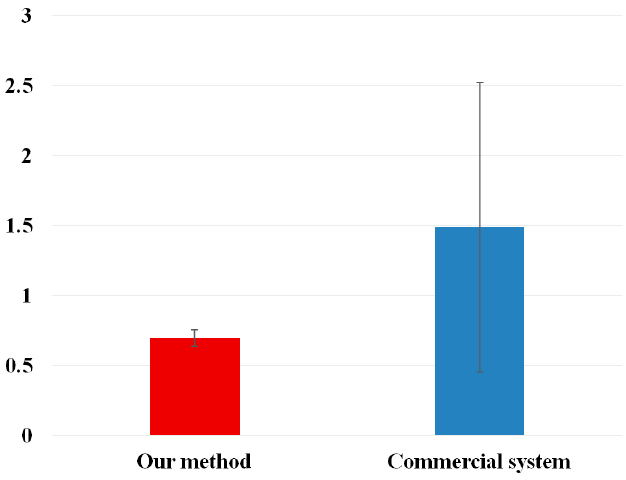
Figure 11. T-test of average gaze detection errors by our method and a commercial system (TheEyeTribe).